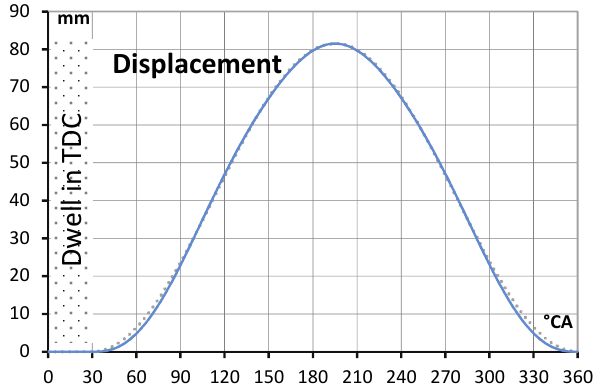
Fig. 7. Calculated displeacement (red line) against the background of the base function (gray line)